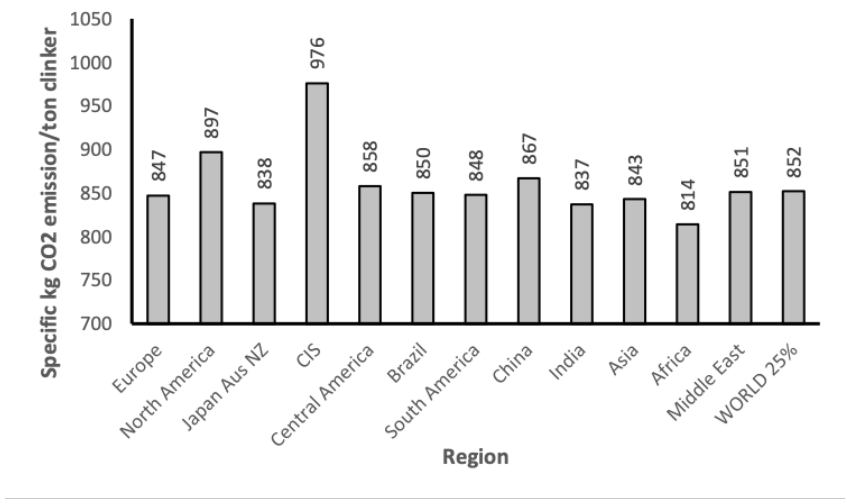
Figure 1. Distribution of CO 2 emissions related to 25% of world cement production (data from